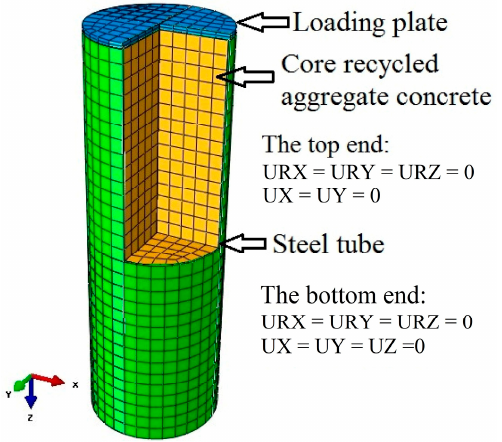
Figure 1. Axial load–mesh size curve.